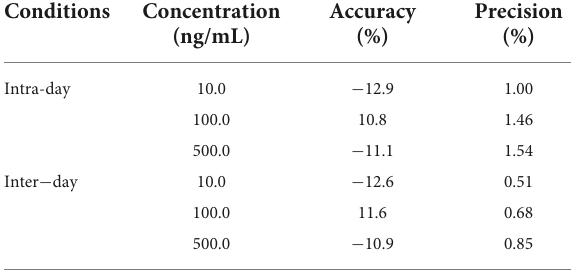
FIGURE3 Plot of back-calculated concentrations of calibration standards of FLC. The standard curve equation was Y = 0.1742C–2.8763 ( n = 5). The limits of detection for this method were in the range from 5.0 to 1000.0 ng/mL. The representative results of three independent experiments are shown.